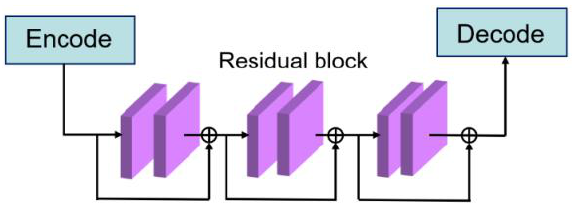
Figure 13. The residual blocks between the encoder and decoder.